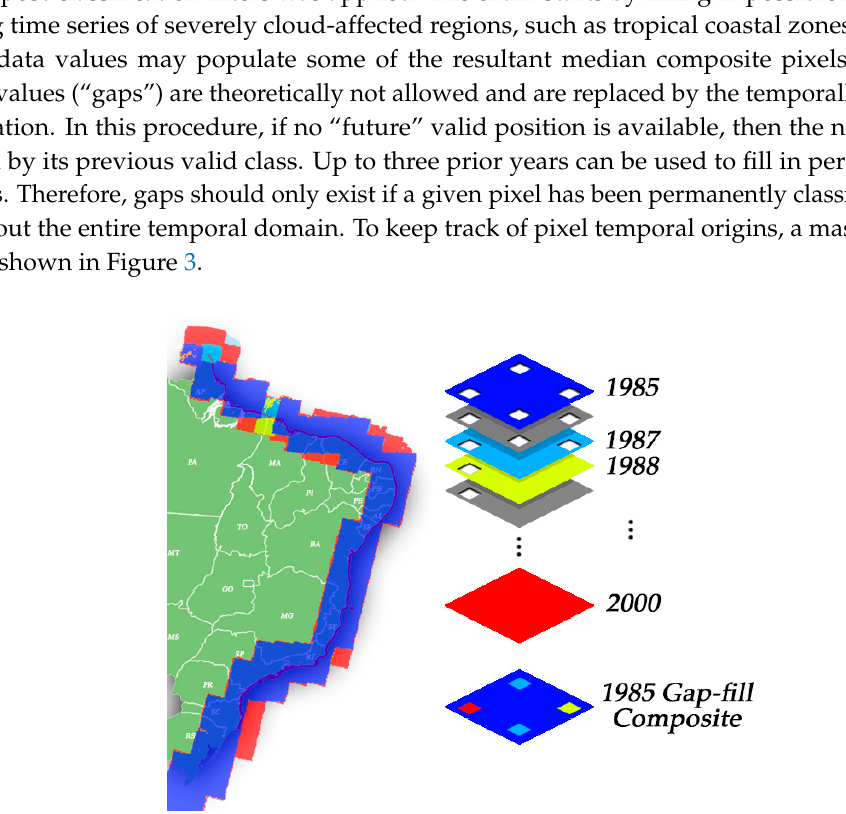
Figure 3. Gap-filling mechanism. The next valid classification replaces existing no-data values. If no “future” valid position is available, then the no-data value is replaced by its previous valid